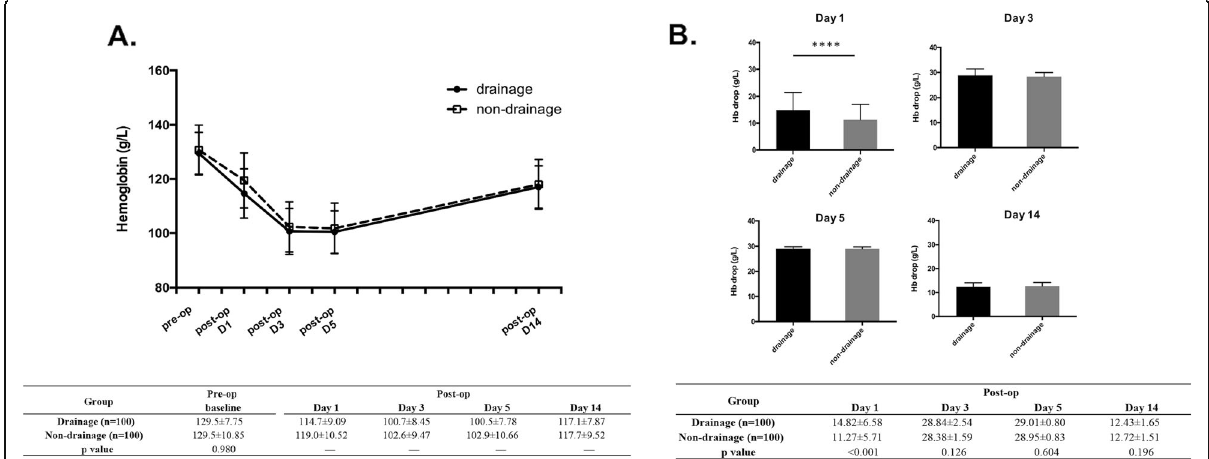
Fig. 2 Effect of drainage on hemoglobin level after TKA. a . the dynamic change of Hb level; b . Hb drop at different time point compared with baseline level